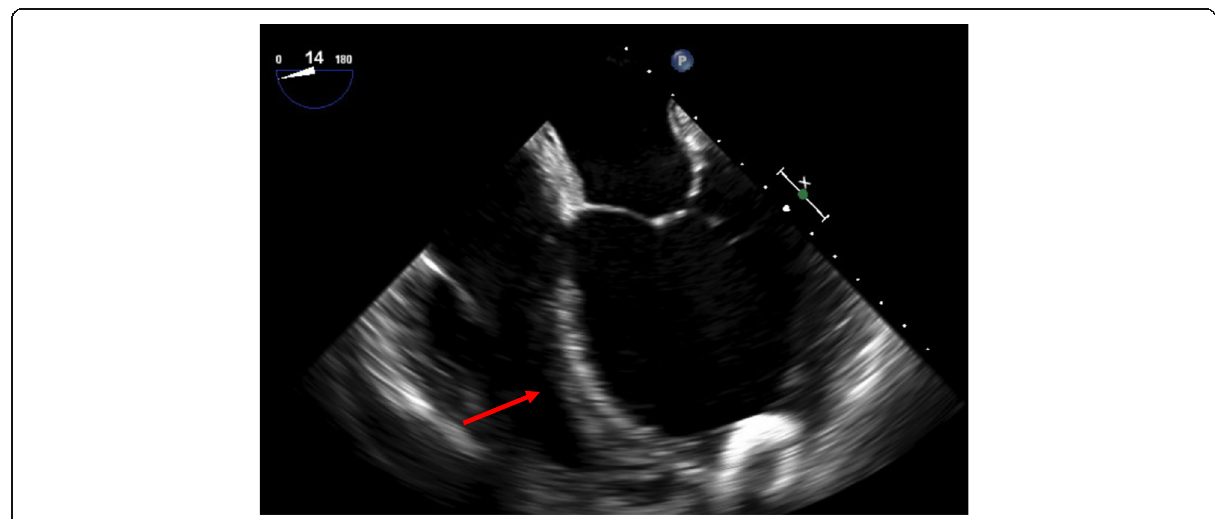
Fig. 2 Transesophageal echocardiogram image showing bowing of the intraventricular septum bulging to the right during diastole. Arrow indicates intraventricular septum bowing